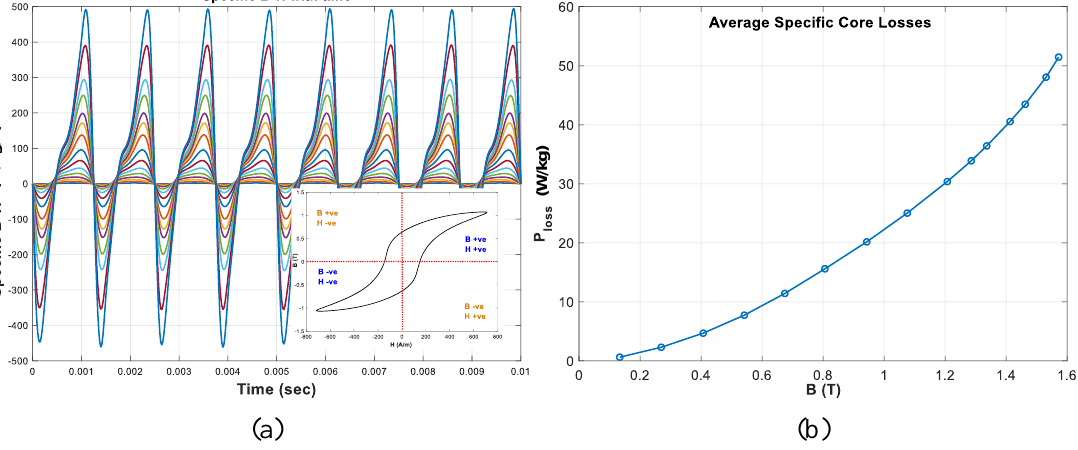
Figure 10. The measured magnetic properties of NO20. ( a ) The measured normalized BH curve. ( b ) The relative magnetic flux permeability.